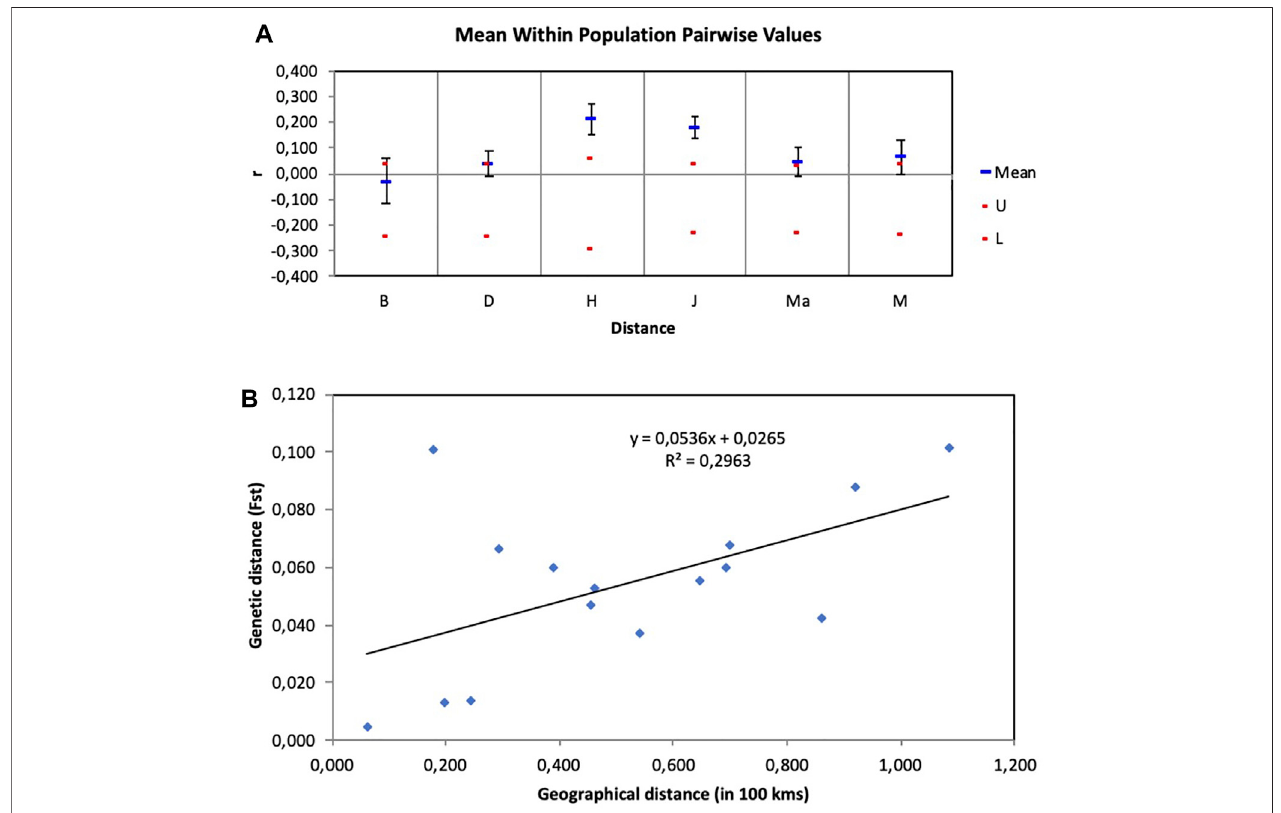
FIGURE5|(A) Assessmentofrelatednesswithinwildrooibospopulations.B — Blomfontein,D — Dobbelaarskop,H — Heuningvlei,J — Jamaka,Ma — Matarakopje, M — Melkkraal. U — upper con fi dence limit, L — lower con fi dence limit. (B) Isolation by distance (IBD) graph using genetic distance measured in F ST estimates and geographical distance measured in 100